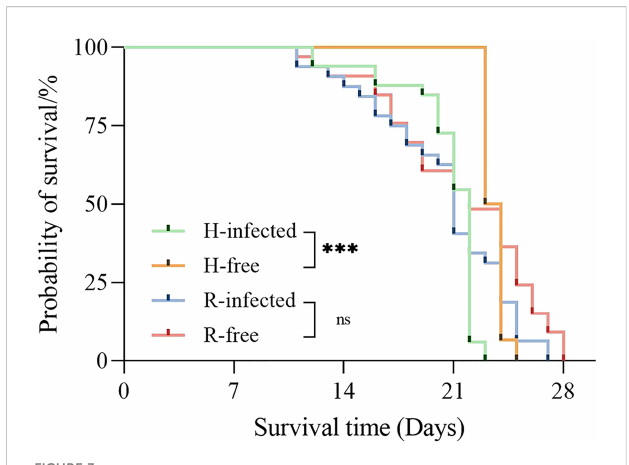
FIGURE 3 Survival curves of different aphid strains. The asterisk indicates signi fi cant differences based on the Log-rank (Mantel-Cox) test, *** P <0.001, and ns nonsigni fi